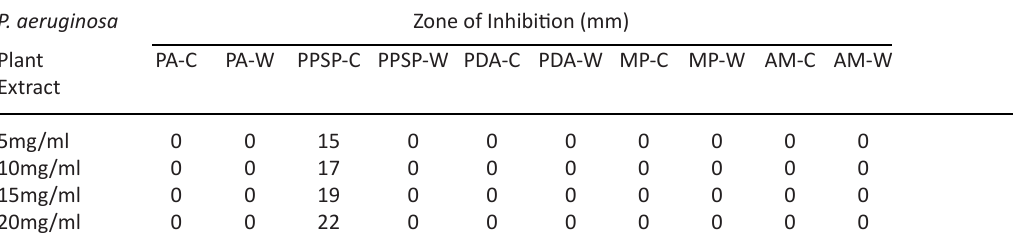
Table 5. Zone of Inhibition by plant extracts against Pseudomonas aeruginosa P.